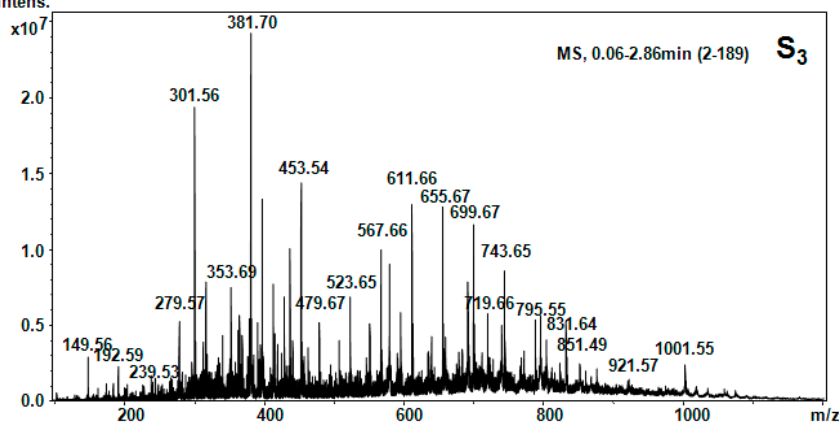
Figure 5. Positive ion mode nano-ESI-Chip-MS for S 3 hellebore fraction.